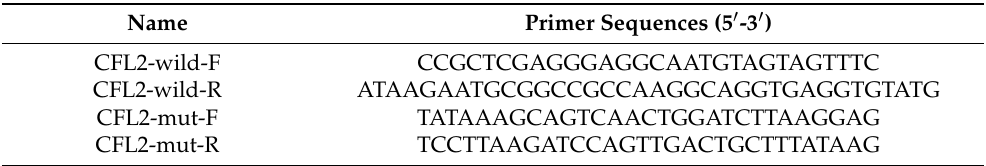
Table 2. Primer information (containing protective bases and restriction sites) for dual luciferase report